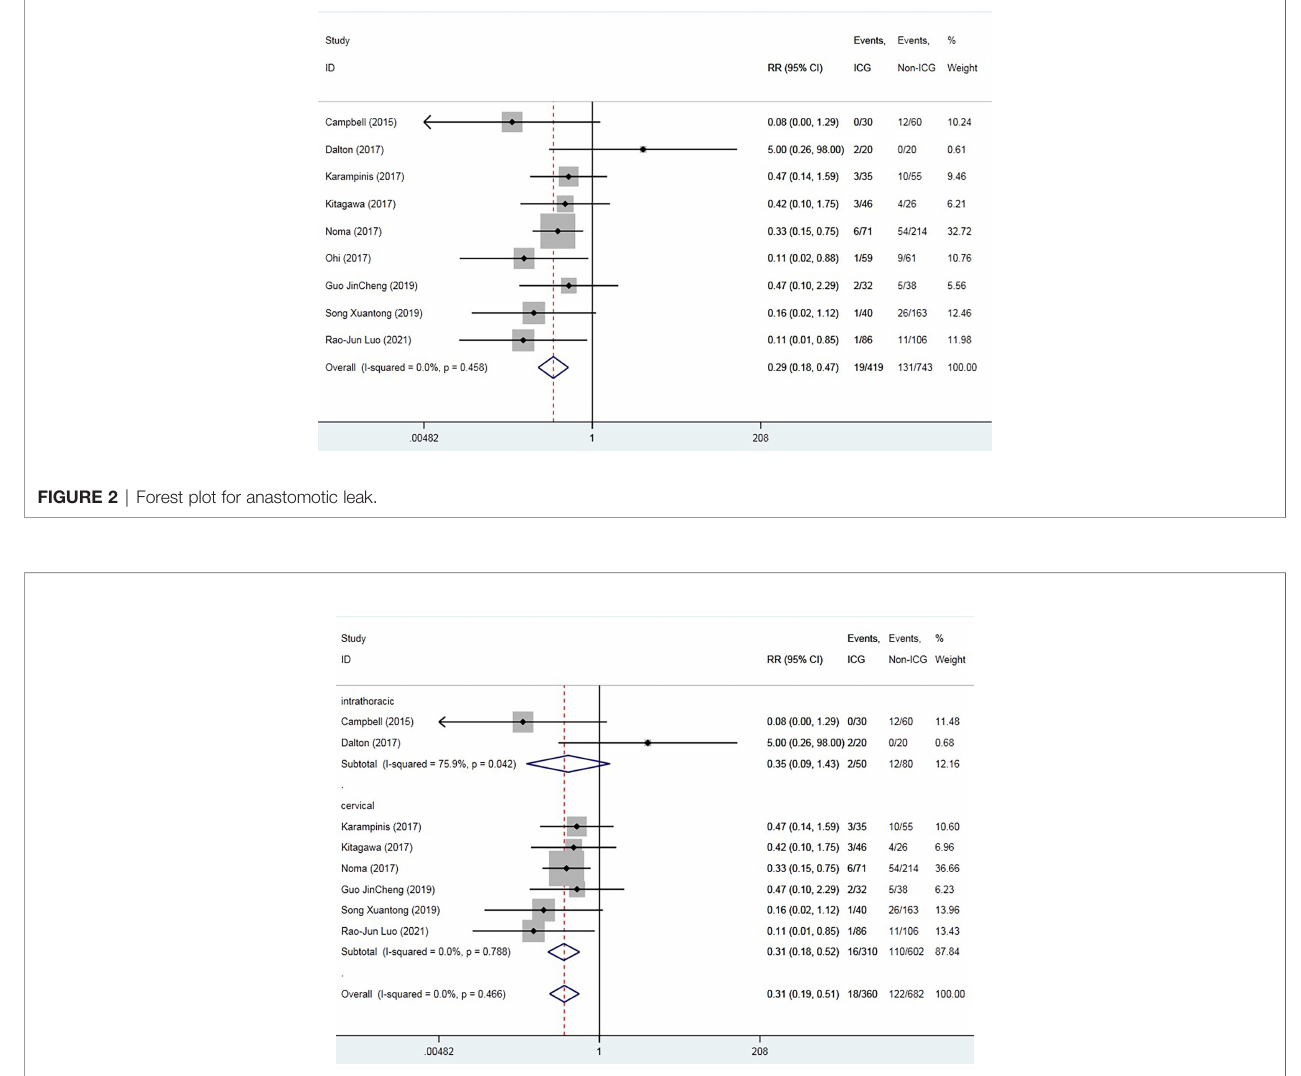
FIGURE 3 | Forest plot for subgroup analysis of anastomotic leak based on anastomosis